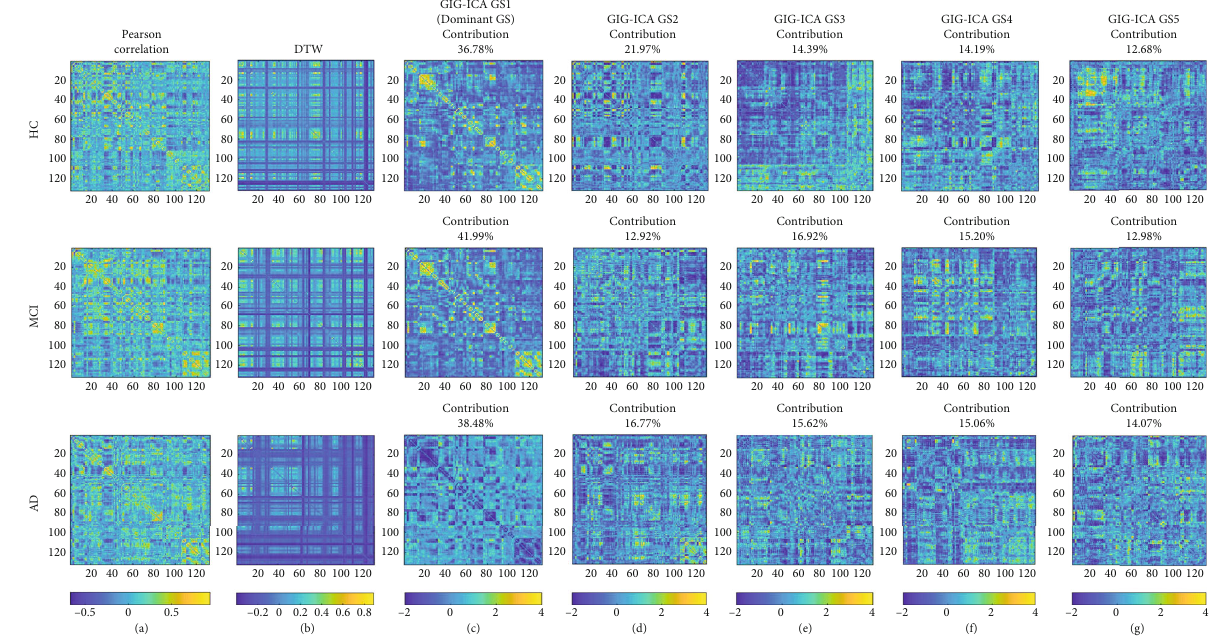
Figure 2: rs-FC adjacent matrices. (a) FC matrices computed with Pearson correlation, and (b) was obtained with DTW. (c) Dominant component of GIG-ICA decomposition. From top to bottom, the fi rst, second, and third rows denote examples from subjects in HC, MCI, and AD groups, respectively.